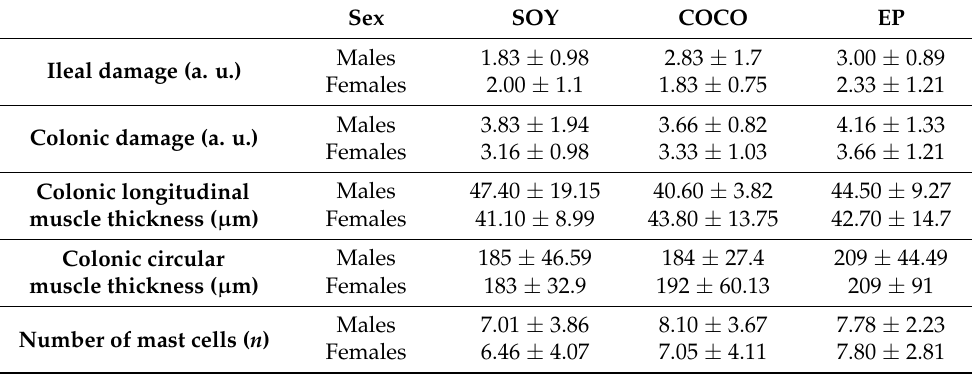
Sex SOY COCO EP Males Males Males Males 185 ± 46.59 Females 183 ± 32.9